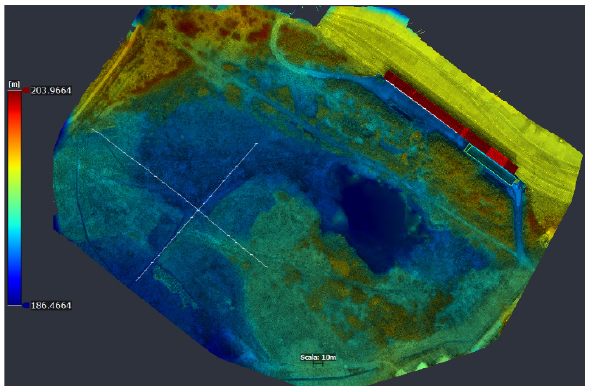
Figure 4 . Santa Barbara exhausted mine area subject to environmental restoration (RPAS Survey,